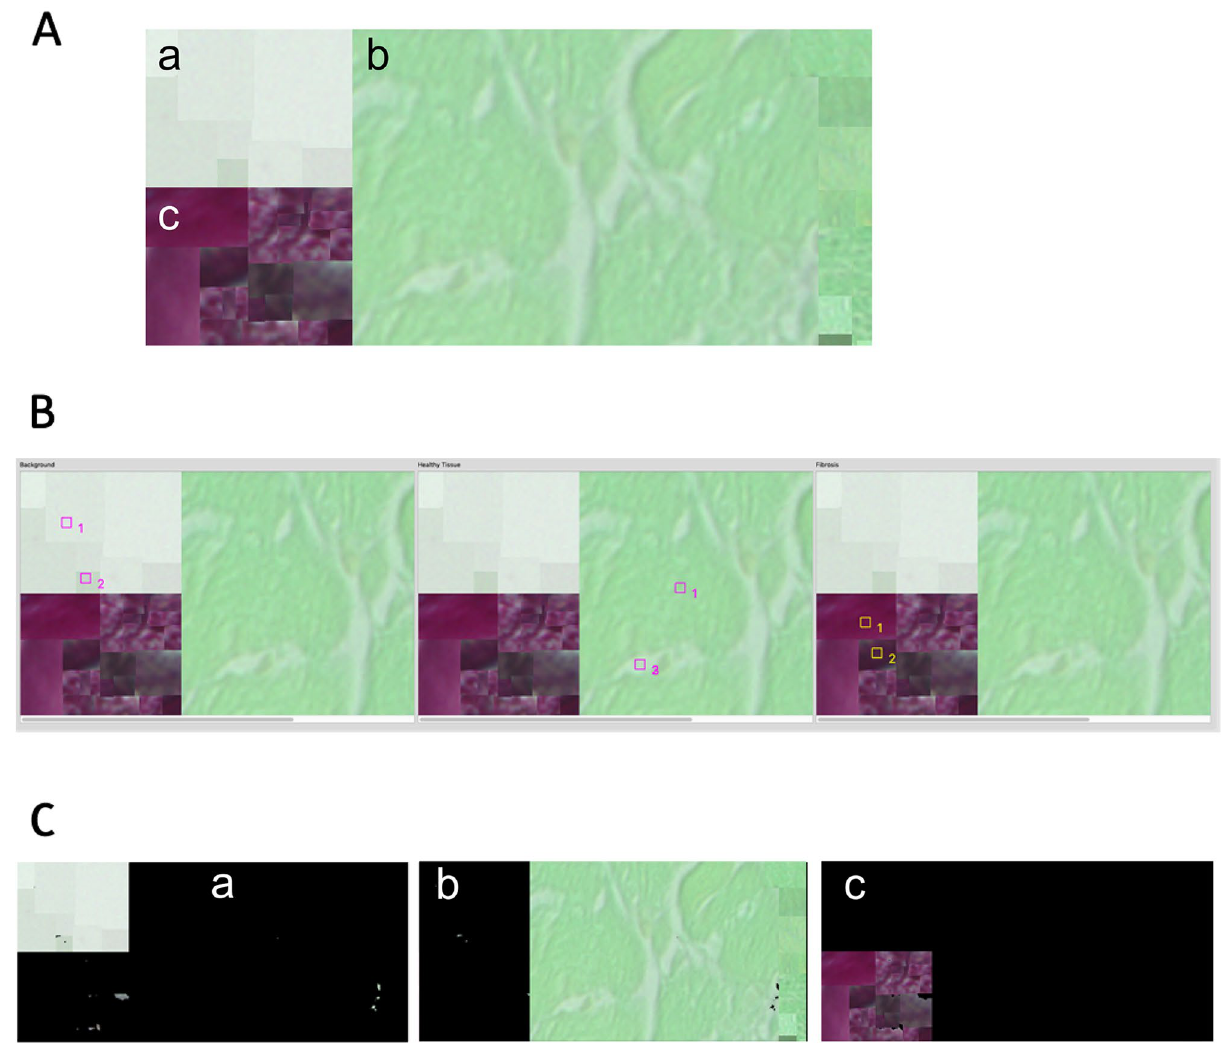
Figure 6. Reference chart and results of accuracy analysis. ( A ) Defined reference chart which combines randomly selected samples per tissue type and then arranged for accuracy evaluation: (a) healthy tissue, (b) fibrotic tissue samples, (c) background samples. ( B ) Selected sample color points for reference tissue associated subclasses for our k -means algorithm. ( C ) Resulting image masks of FibroSoft cluster analysis using supervised k -means with subclasses obtained from a run on the defined reference image; (a) identified as healthy tissue, (b) classified fibrotic tissue, and (c)